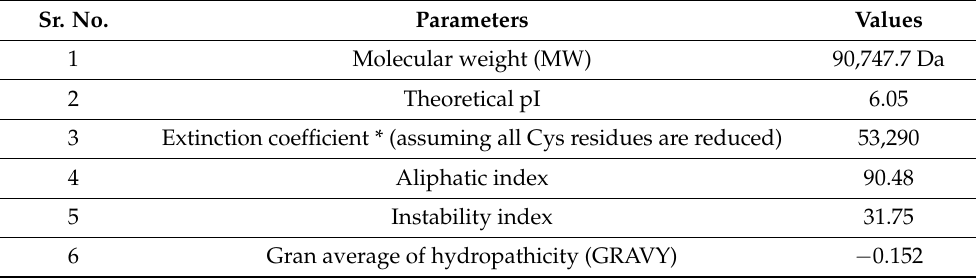
Table 3. Physiochemical properties of urease by ProtParam. Sr.